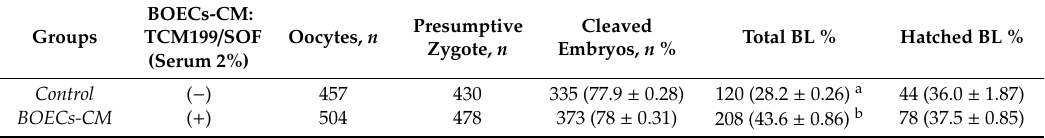
Table 1. E ff ect of BOECs condition media on embryonic development during in vitro